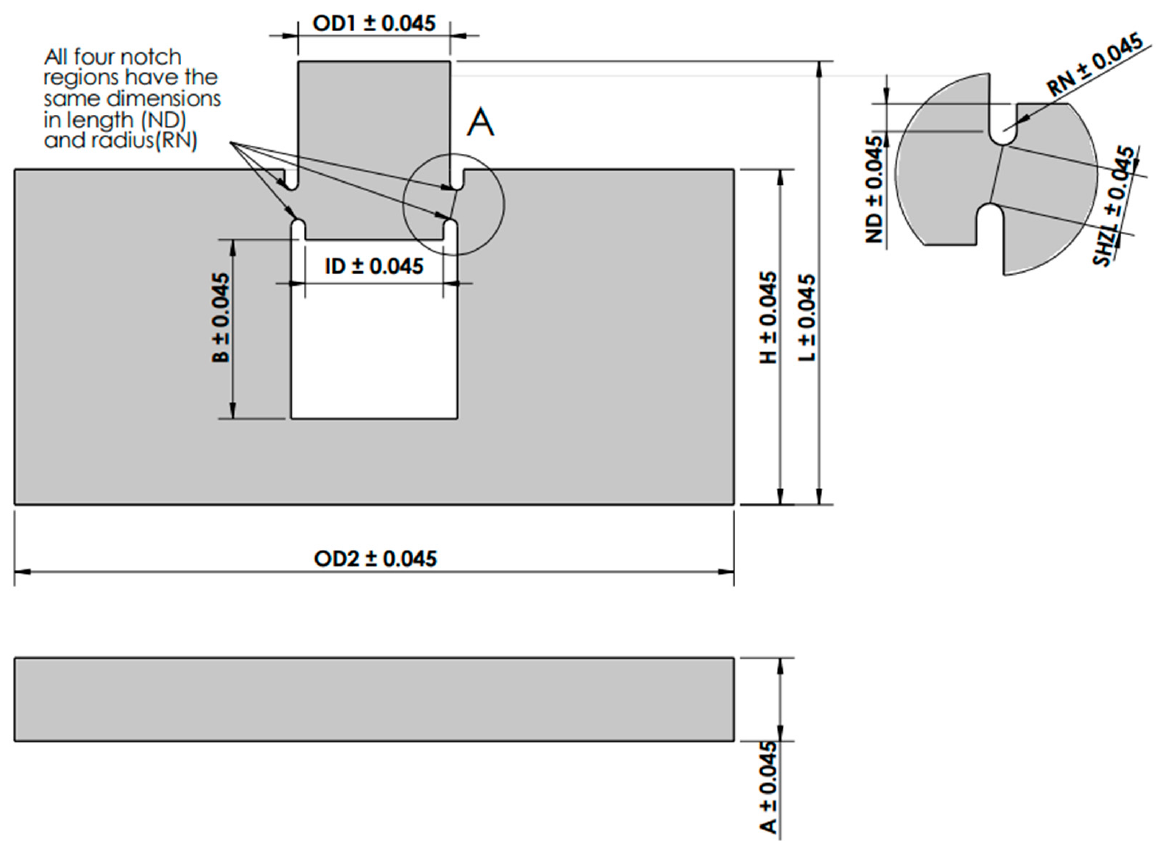
Figure 3. Flat Hat-Shaped Specimen illustrated with given dimensions and detailed variables given in Table 2. Table 2. Dimensional parameters utilized for shear specimens.